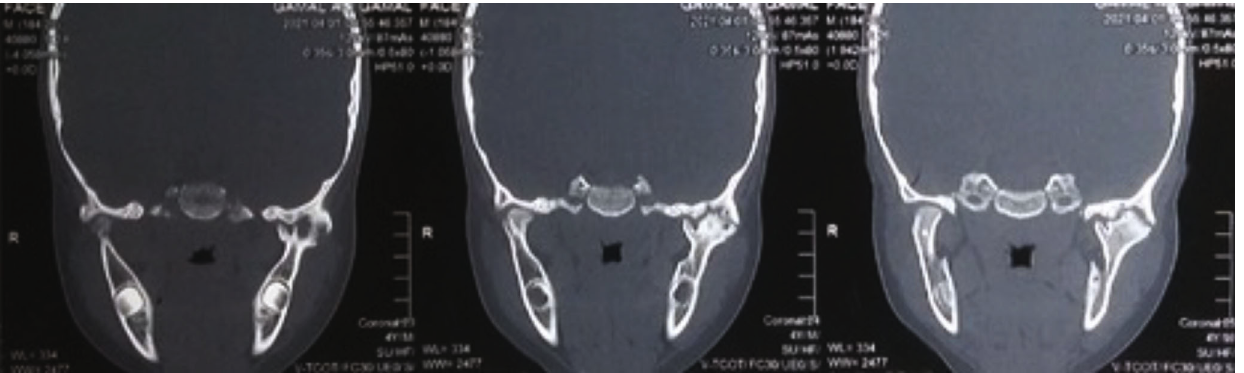
Figure 4: A coronal CT scan view showing left TMJ